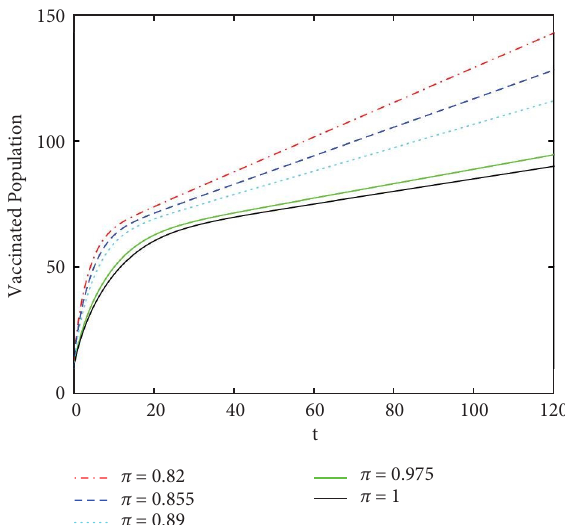
Figure 12: Te dynamics of vaccinated human population for various fractional orders υ and for fractal order π � 0 . 5.